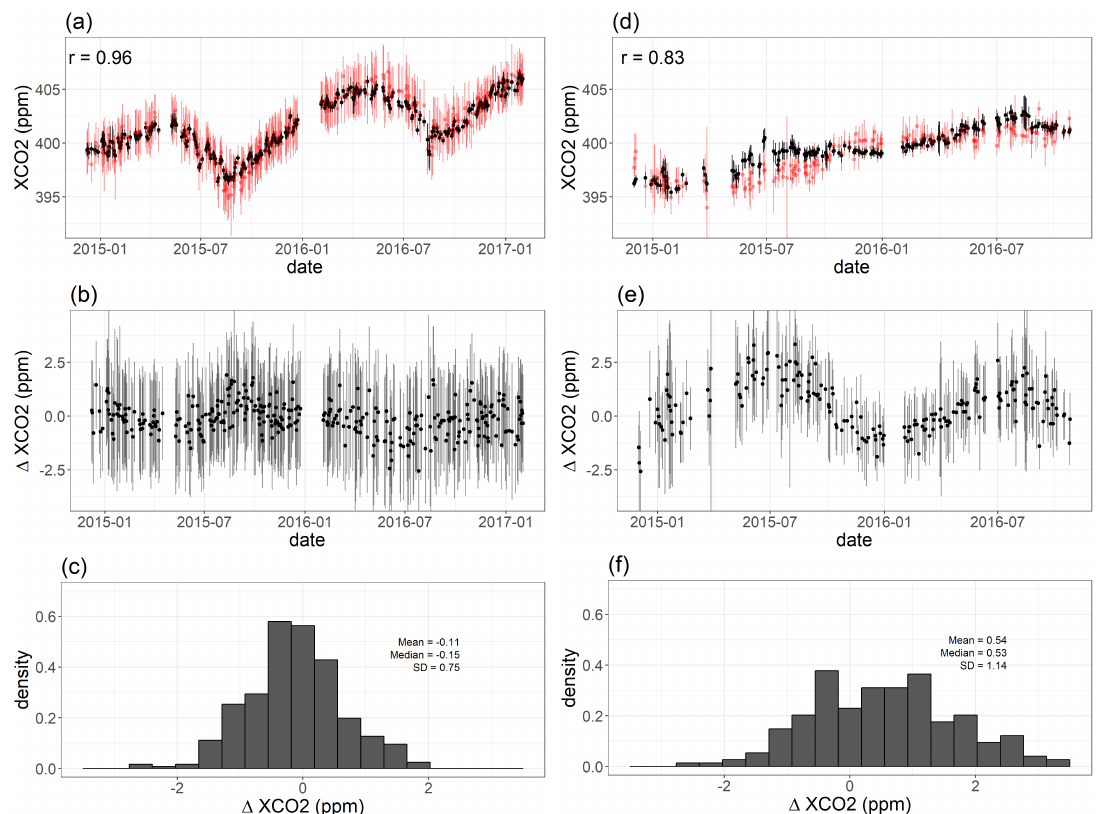
Figure 9. Comparison between the Total Carbon Column Observing Network (TCCON) measurements of XCO 2 and the fixed rank kriging (FRK) Version 7r product. ( a ) Time series plots for the TCCON data (red) and the FRK product (black) at Lamont, Oklahoma. The black bars are the TCCON data ± 2 times TCCON’s measurement-error standard deviation, while the red error bars are the FRK predictions ± 2 times the prediction standard error, respectively. ( b ) The differences between the TCCON measurements and the FRK predictions at Lamont, where the error bars are the difference ± 2 times the square-root of the sum of the TCCON error variance and the FRK prediction variance. ( c ) Histogram of the differences between the TCCON measurements and the FRK predictions at Lamont. ( d – f ) Same as ( a – c ), but for the TCCON station at Wollongong,